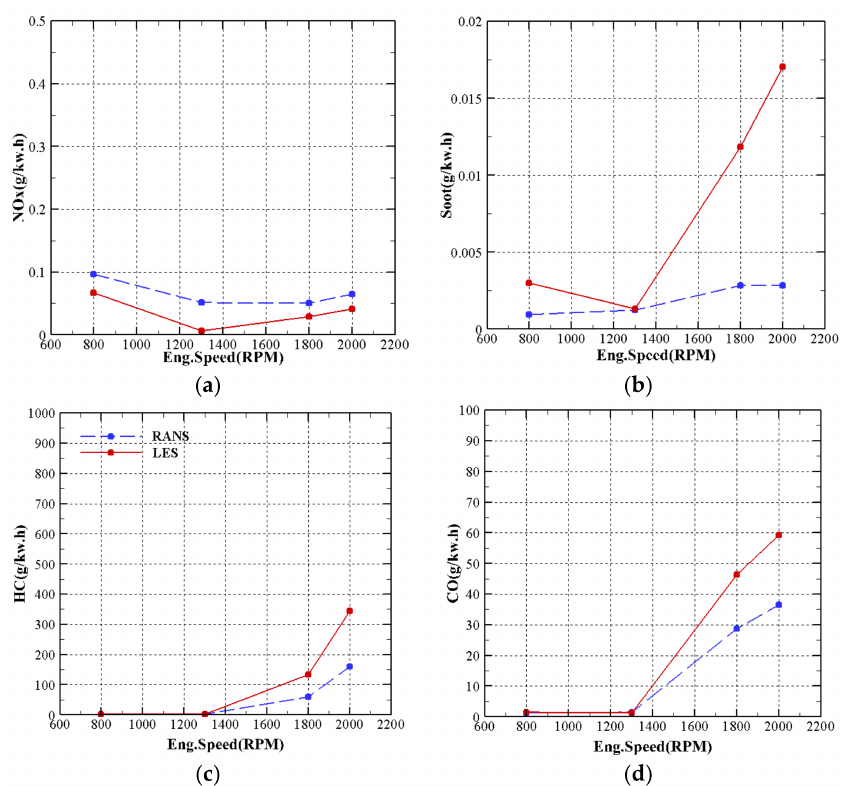
Figure 15. Comparison of LES and RANS model for: ( a ) NO x , ( b ) soot, ( c ) HC and ( d ) CO emissions with different engine